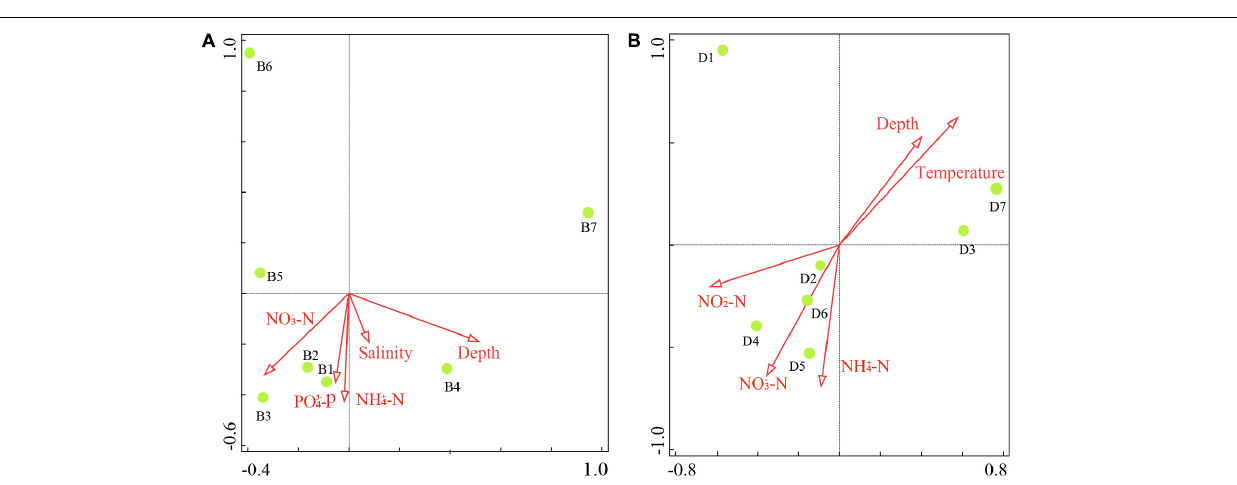
during the survey. However, this large catch only accounted for a 16.52 kg total weight and the average individual weight was only 2.76 g. In winter, the eDNA approach still indicated that there